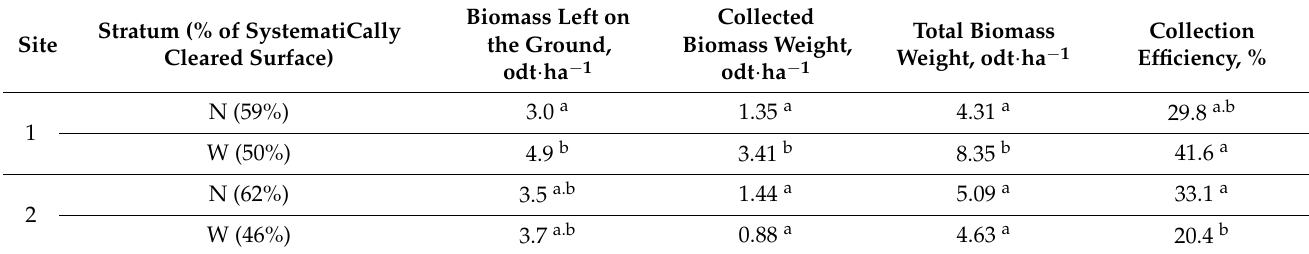
Table 3. Biobaler collection efficiency (the different superscript letters indicate statistically significant differences at 95% probability). Acronyms: N, narrow; W, wide; odt, oven dry tonne; ha, hectare. Stratum (% of Site